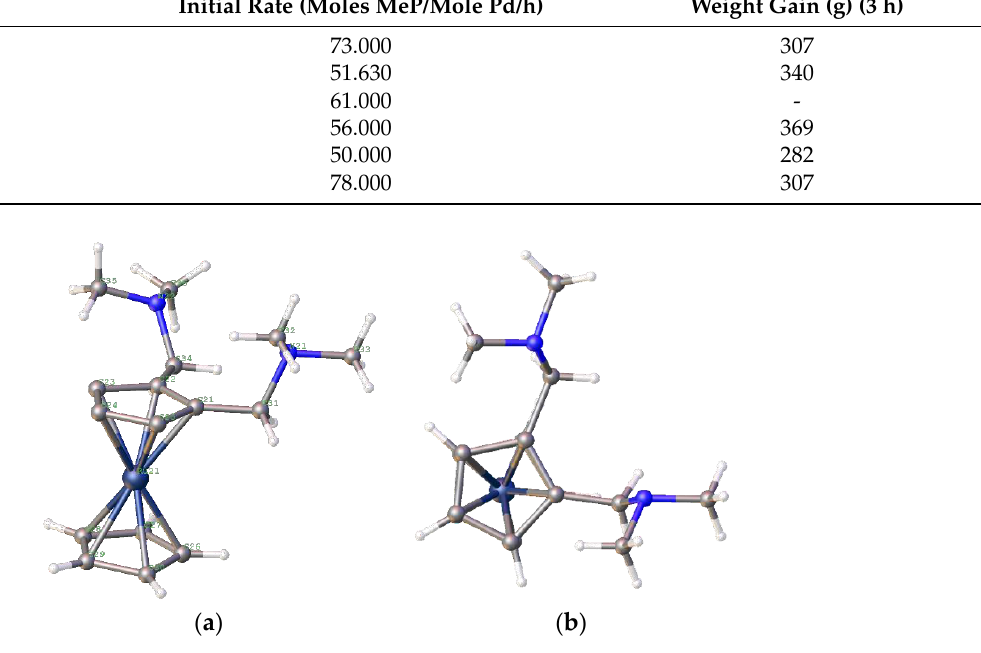
Figure 20. ( a ) Side and ( b ) top views of the crystal structure of the bis-methylamine of ruthenocene, compound 26 .